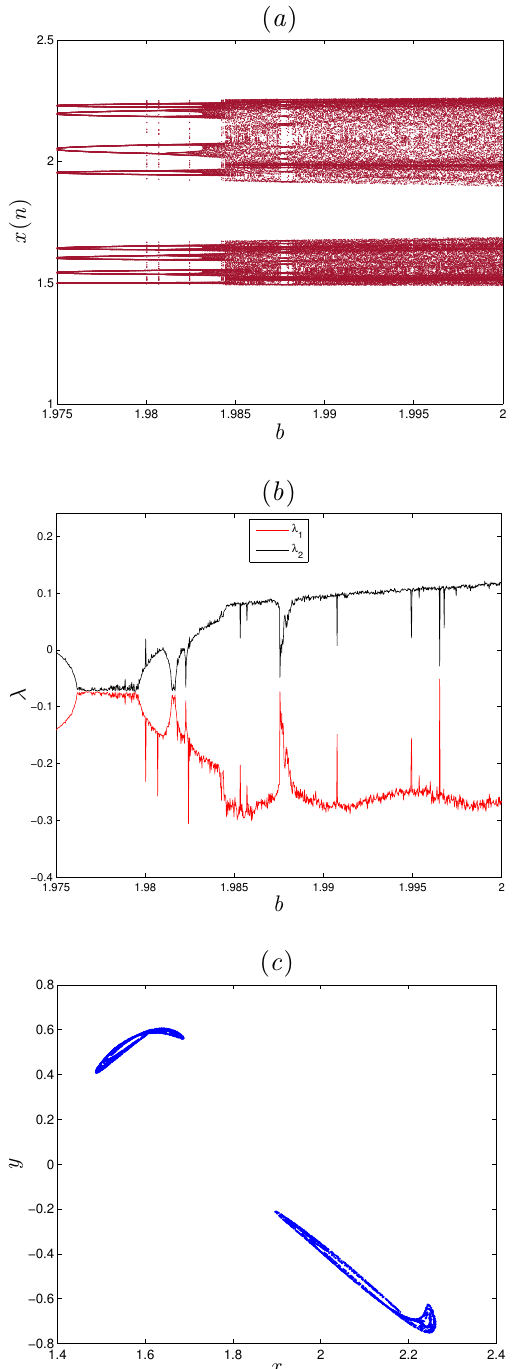
Figure 1. Numerical analysis of system (1) with ( x 0 , y 0 ) = ( 1.7 − 0.39 ) : ( a ) bifurcation diagram with the variation of b ; ( b ) Lyapunov exponents with variation of b ; ( c ) hidden chaotic attractor for b =